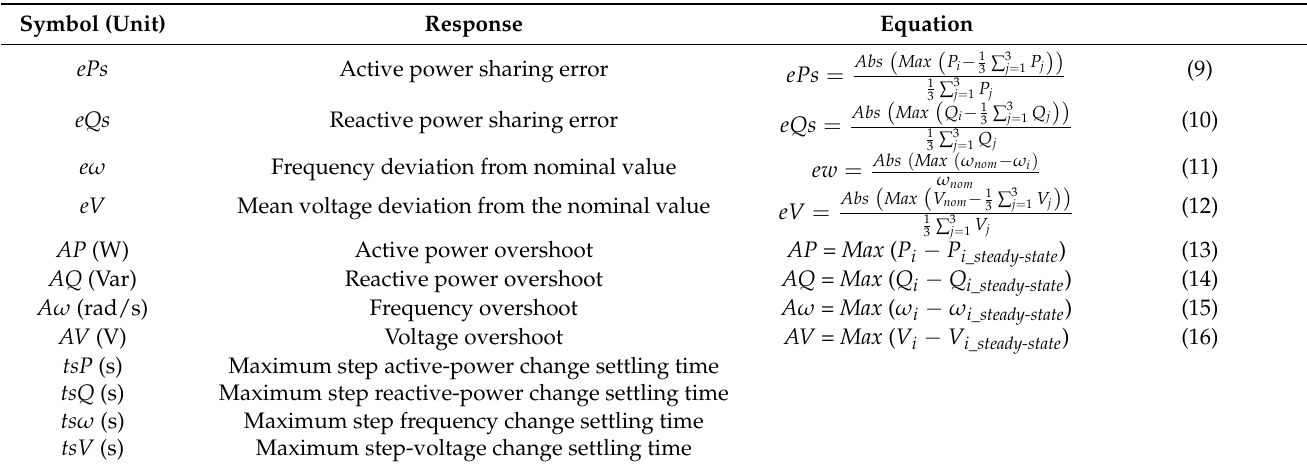
Table 2. Merit responses for the studied